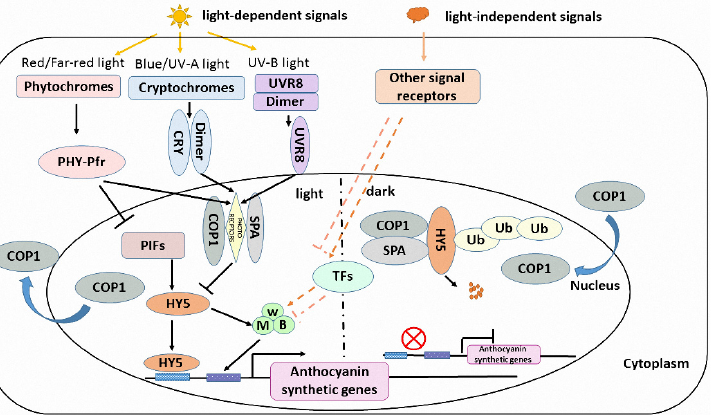
Figure 3. A simplified model of light-dependent and -independent regulation of anthocyanin biosynthesis in plants. During light-dependent anthocyanin biosynthesis, photoreceptors sense different wavelengths of light and are activated to be transferred into the nucleus, then the HY5- COP1-SPA complex is rearranged to dissociate HY5 protein and to avoid the degradation of HY5 transcription factors. HY5 positively regulates the expression of anthocyanin biosynthetic genes and lead to pigment accumulation. During light-independent anthocyanin biosynthesis, positive or negative transcription factors are activated or suppressed to form an MBW complex regulating the expression of anthocyanin biosynthetic